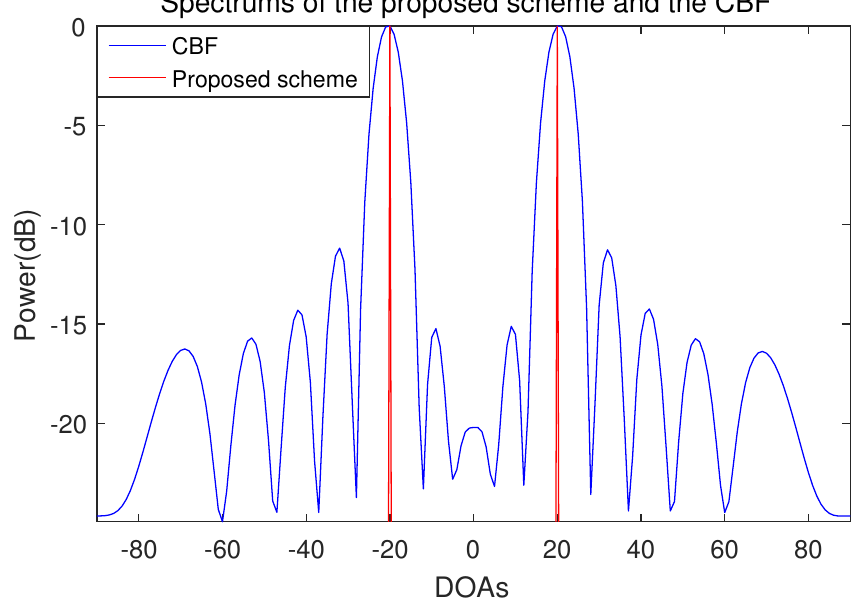
Figure 2. Spectrum of the proposed scheme and the conventional beamforming algorithm when the number of sensors is 15, the number of samples is 1000 and the incident angles are − 20 ◦ and 20 ◦ (SNR = 10 dB).